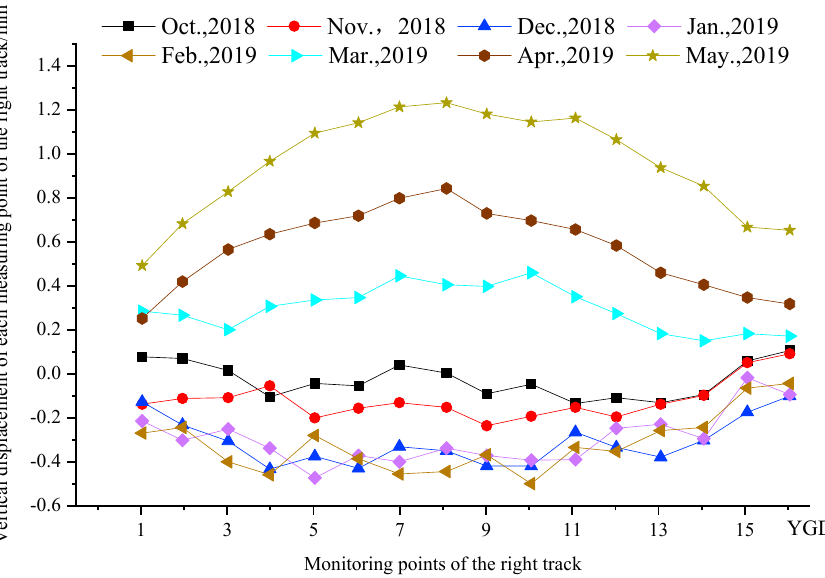
Monitoring points of the right track Figure 13. Vertical displacement time − history curve of each monitoring point of the right track. The time-history displacement data of the right track measuring points YGD-4, YGD-7 and YGD-12 are analyzed, as shown in Figure 14. The right track has a stable subsidence trend in the construction stage of the foundation pit retaining structure, and the subsidence error of each measuring point is small. When the vertical displacement of the track is in excavation stages 1 and 2, that is, the excavation depth of the foundation pit is 3.5 and 6.5 m, the vertical displacement of the track maintains a stable downward trend. In excavation stages 4 and 5, when the excavation depth is less than 14.5 m, the vertical displacement of the track has an obvious upward trend. In the pouring stage of the bottom slab, the cumulative displacement increases first and then decreases, and the vertical deformation of the right track is consistent with the deformation trend of the station measuring point.